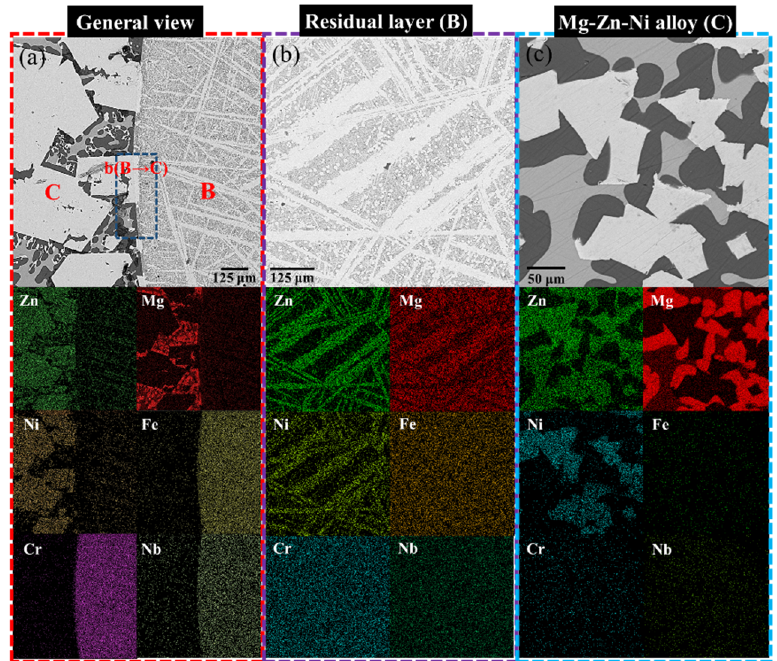
Figure 6. BSE images and elemental mapping of the sample at 800 °C. ( a ) SEM images of residual and Mg-Zn alloy with a boundary; ( b ) SEM image of the residual layer; ( c ) SEM images of Mg-Zn alloy; B-Residual layer rich in Fe and Cr; C-Generated Mg-Zn-Ni alloy.